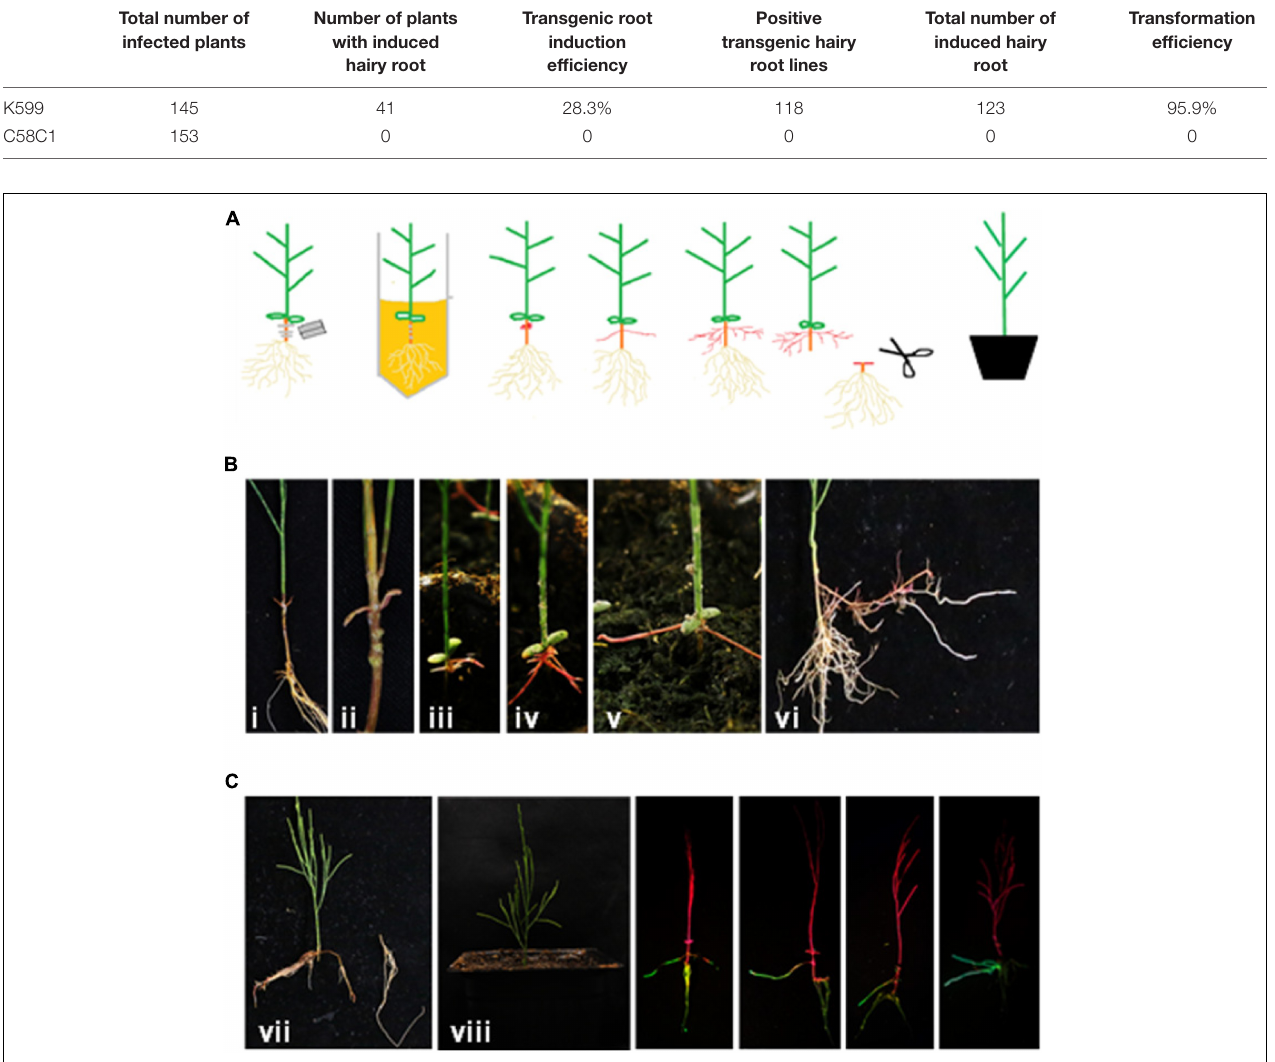
FIGURE 9 | Hairy root transgenic system in Casuarina equisetifolia . (A) Schematic diagram of transgenic system for C. equisetifolia by Agrobacterium rhizogenes- mediated transformation. (B) Process of callus and hairy root regeneration. (i) The 5–8 cm height seedlings for infection; (ii–vii) different stages of callus and hairy root regeneration. (vi) The picture before cutting off the original root, and (vii) the picture of cutting off the original root after transgenic hairy roots fully developed; (viii) seedling with fully developed transgenic hairy roots. (C) GFP signal in transgenic hairy